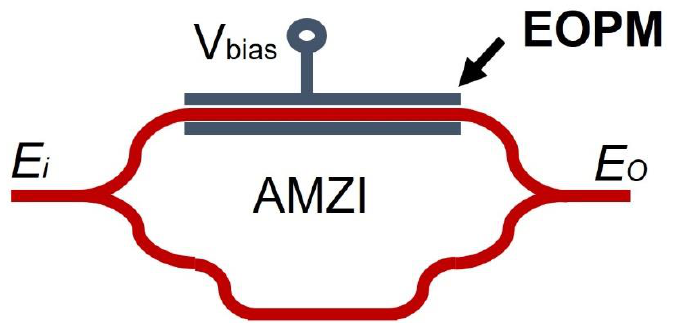
Figure 3. AMZI: Asymmetric Mach-Zehnder Interferometer. EOPM: Phase Modulator. The FSR depends on the length difference between the two paths. By applying voltage on the EOPM, we can adjust the central frequency of the filter. This is an optical filter with a simplified structure and